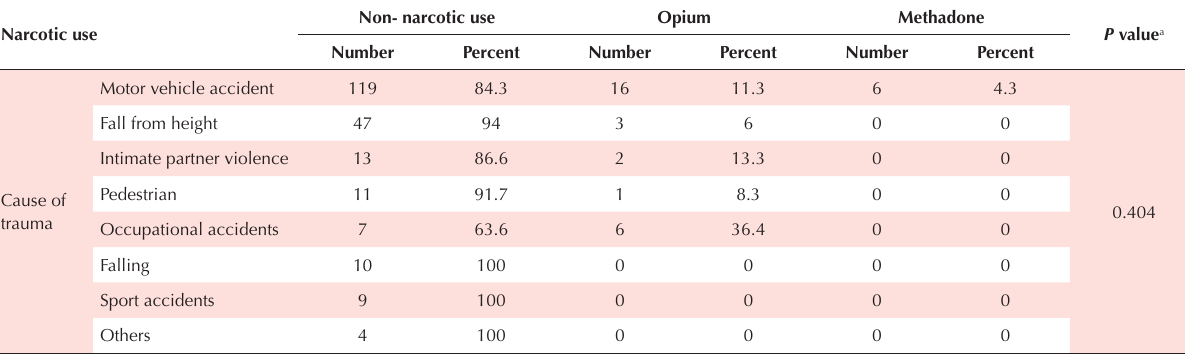
Table 3 . Frequency distribution of opium use among trauma patients by the cause of trauma Non- narcotic use Opium Methadone Narcotic use